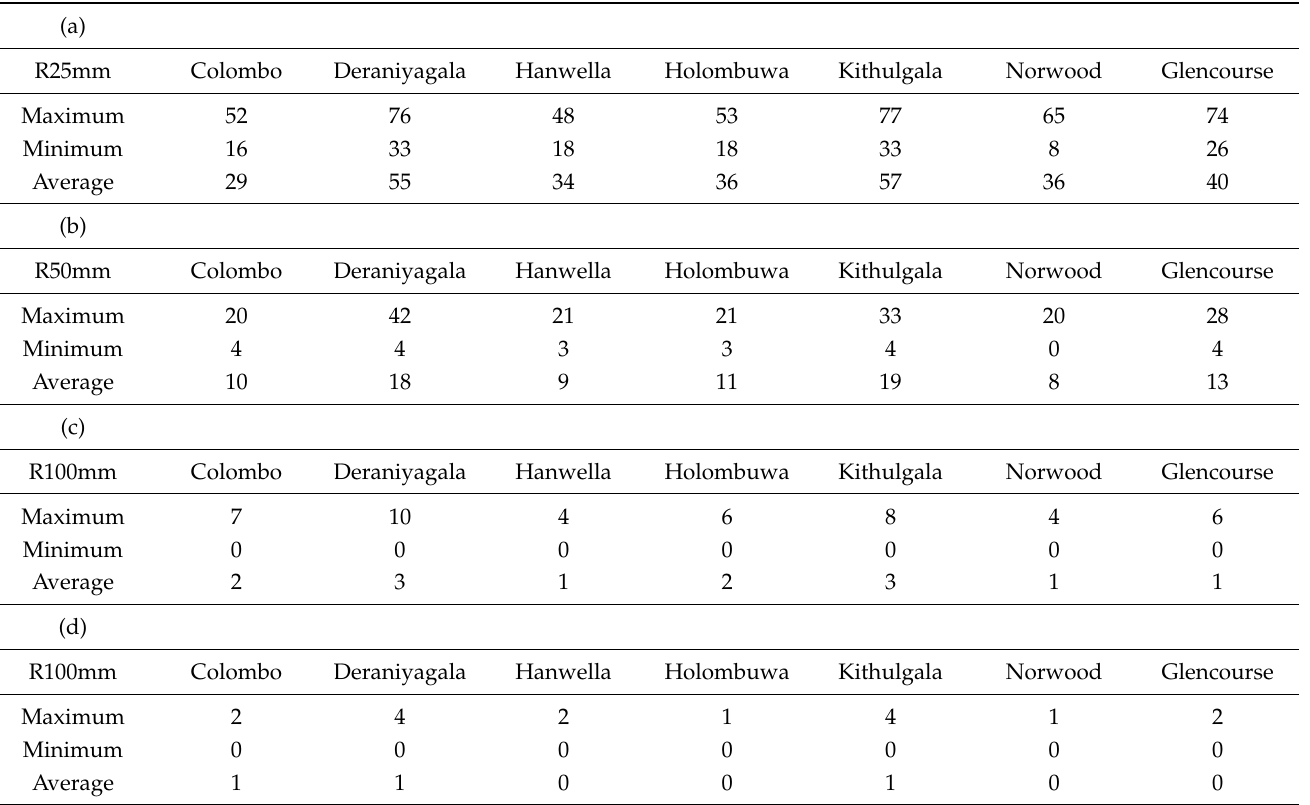
Table 7. Statistics of R10mm, R20mm, and R25mm from 1961 to 2019 for seven stations in the KRB; (a) Statistics of R10mm in the study area, (b) Statistics of R20mm in the study area, and (c) Statistics of R25mm in the study